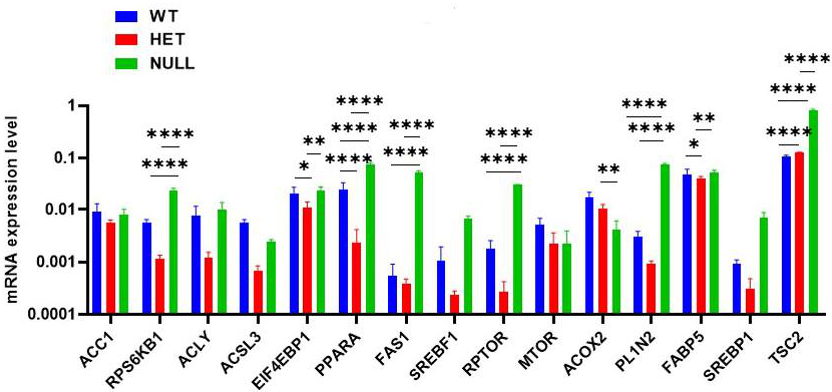
Figure 5. Real-time q-RT PCR analysis of various genes. Gene expression levels were normalized to GAPDH expression. Data are given as mean ± SD. Statistical analysis was performed using GraphPad prism 7 and a two-way ANOVA with Tukey’s multiple comparison post-test, comparing WT vs. HET or WT vs. NULL per condition. Significant differences are displayed: * p < 0.05, ** p < 0.01, and **** p < 0.0001were determined, compared with the control. Experiments were performed in triplicate and repeated two times.